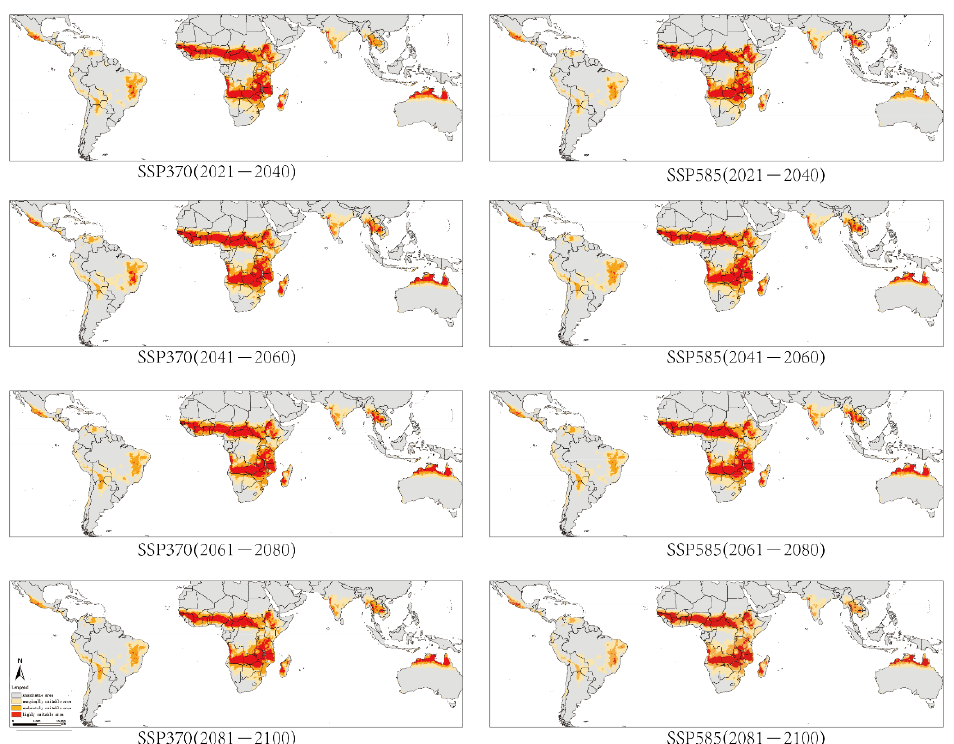
Figure 5. Potentially suitable area for Glossina morsitans under four scenarios from 2021–2100.